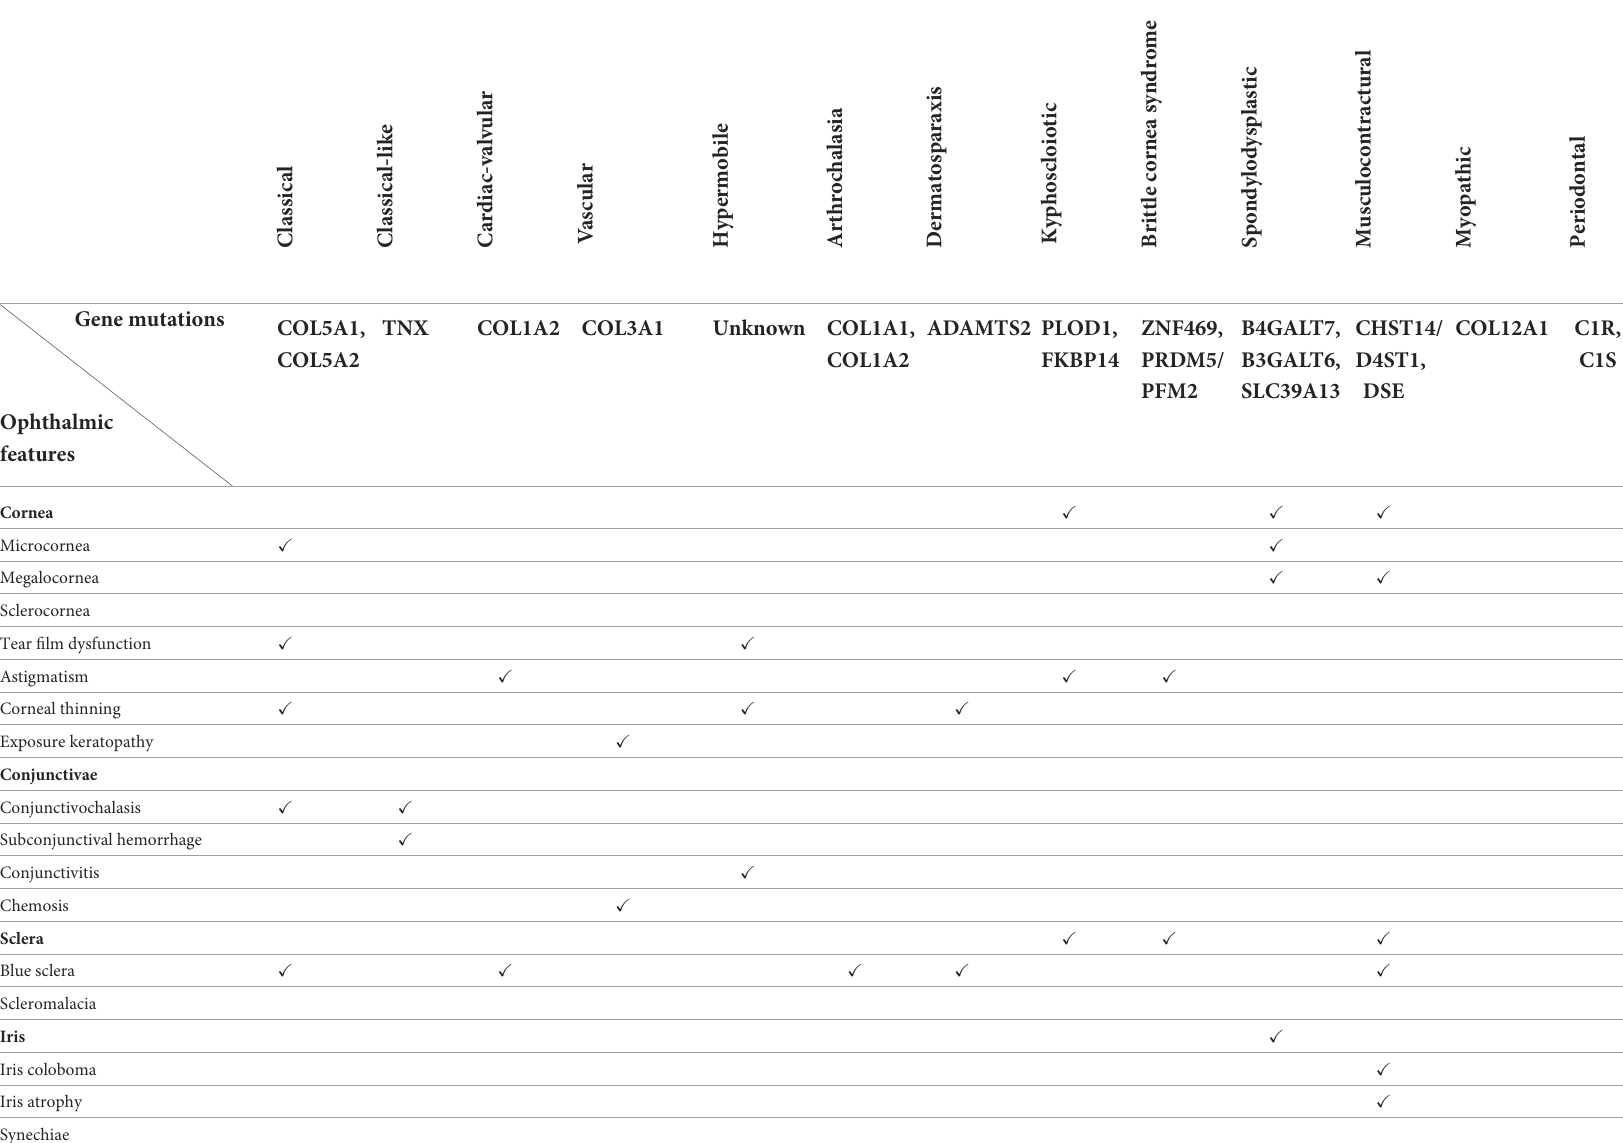
TABLE 1 Ophthalmic manifestations of the 13 Ehlers Danlos Syndrome